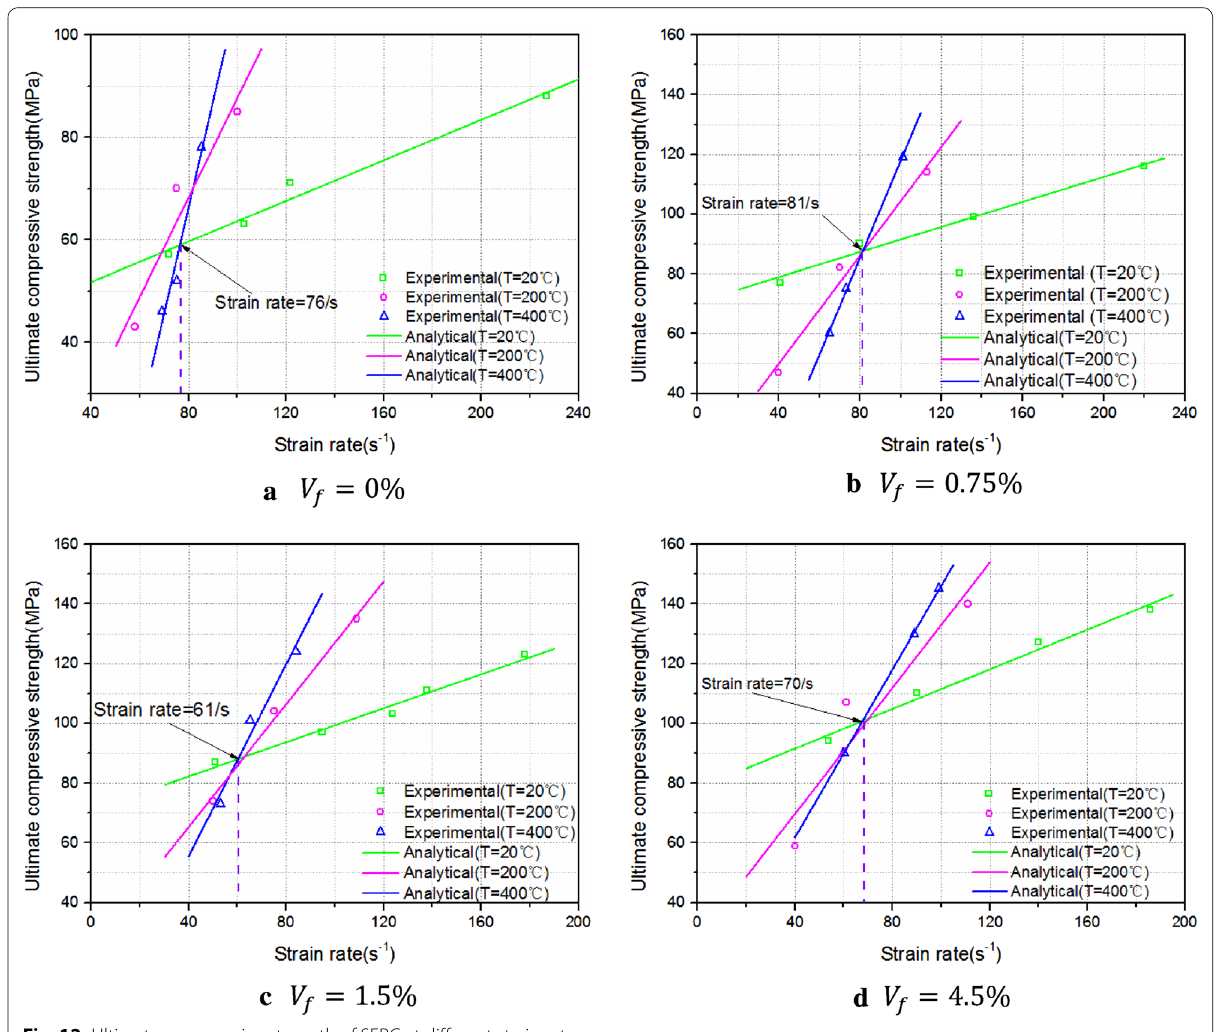
Fig. 12 Ultimate compressive strength of SFRC at different strain rates.